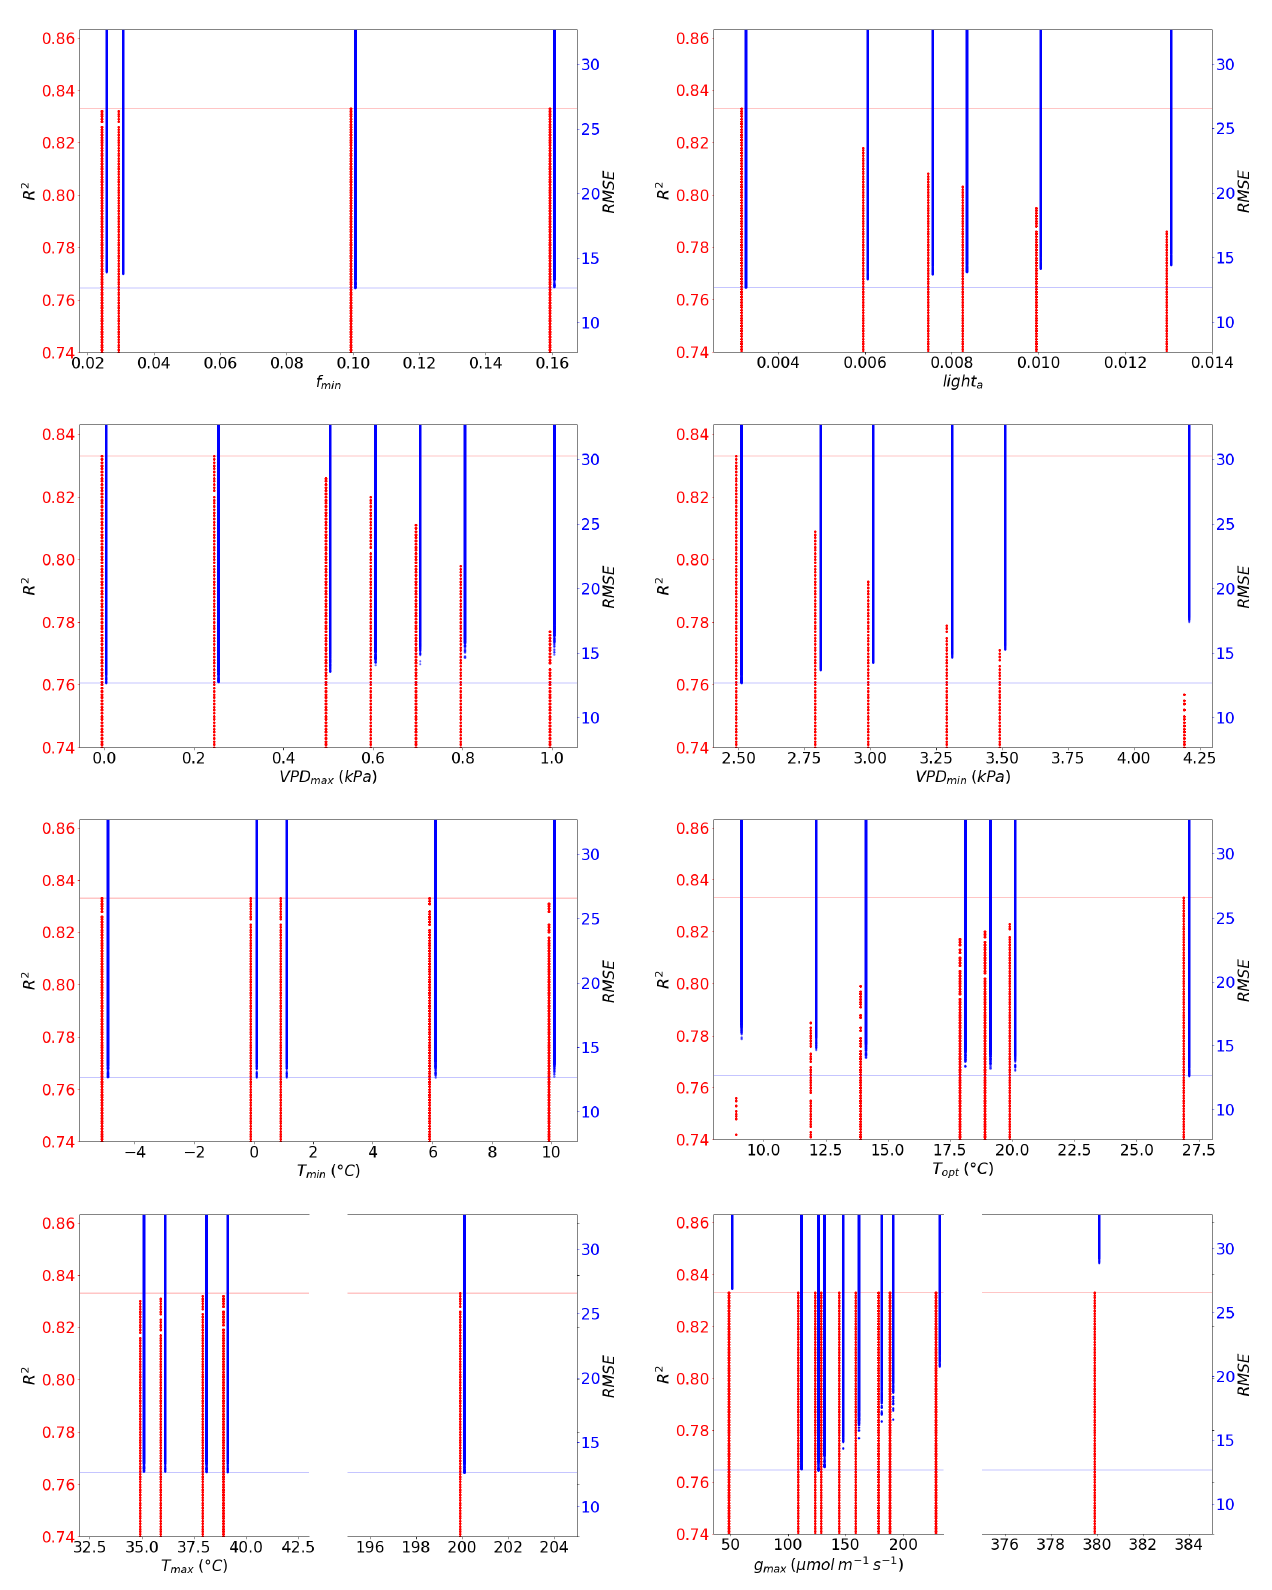
Figure 2. The R 2 and RMSE coefficients from validation of the modified Jarvis model against the WoTA measurements for each set of static parameters in Table